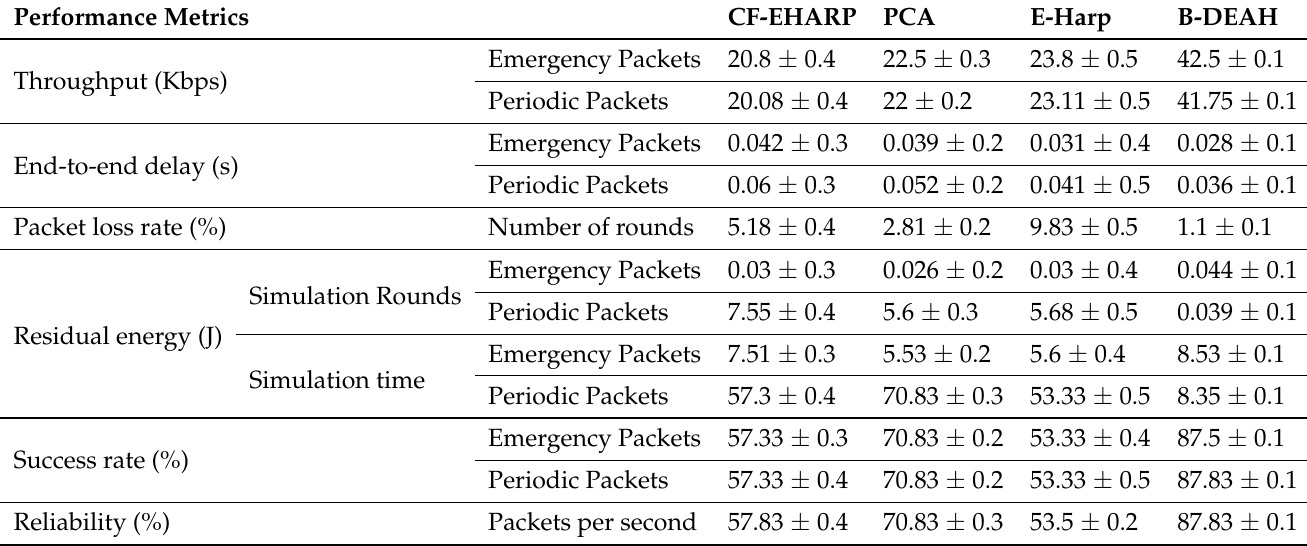
Table 7. Overall comparison of proposed and existing